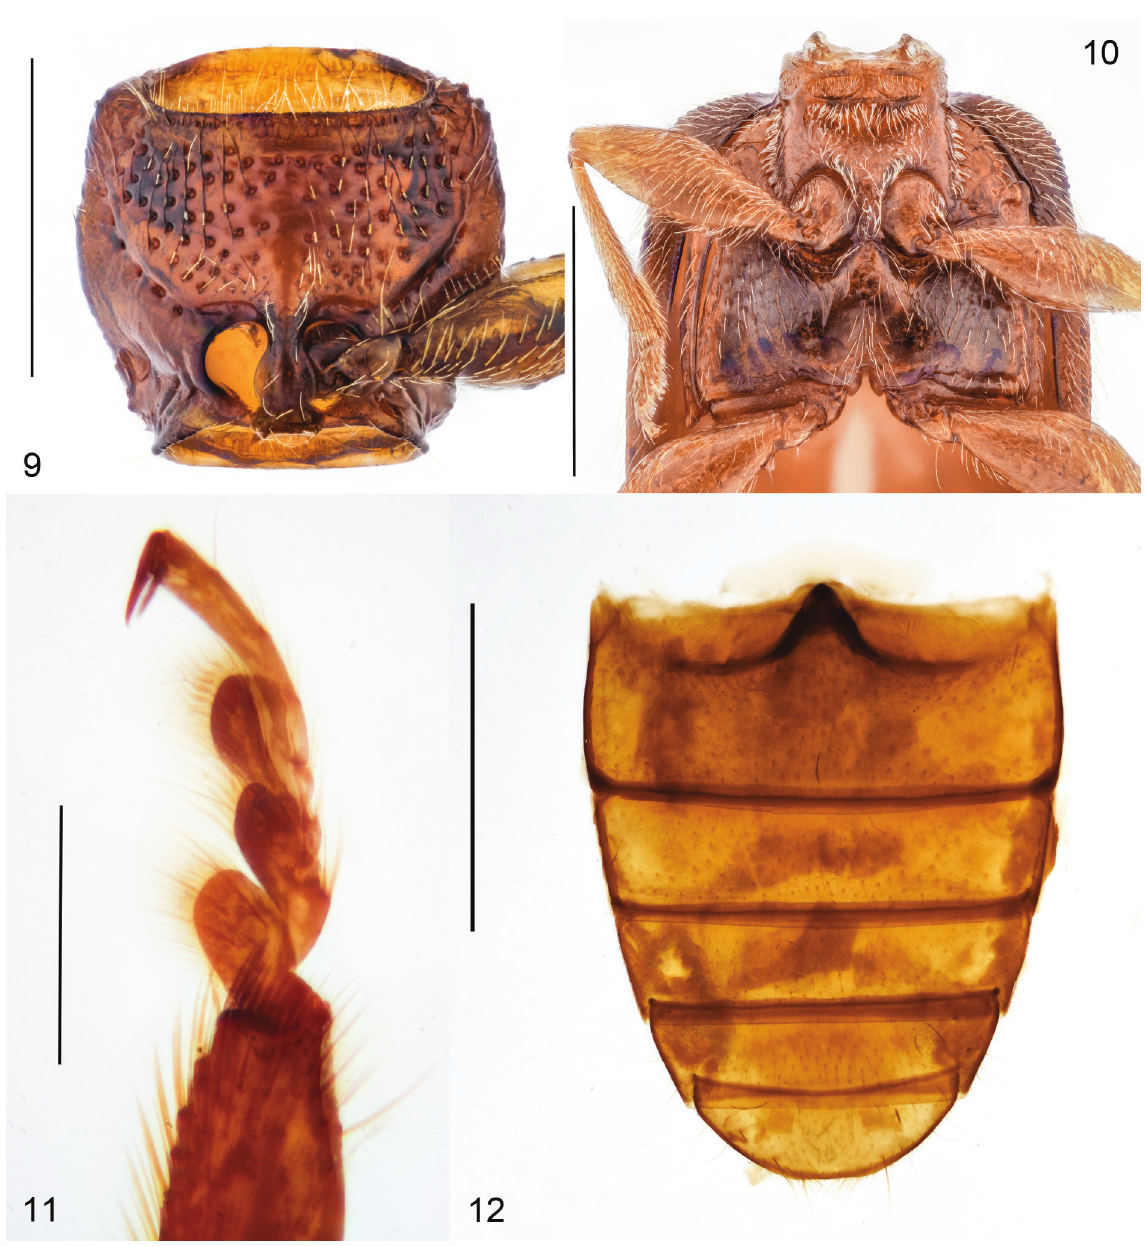
Figs 9–12. Bolianus giannae gen. et sp. nov., paratype. 9 . Pronotum, ventral view (right anterior leg removed). 10 . Meso- and metathorax, ventral view. 11 . right anterior tarsus. 12 . abdominal ventrites. Scale bars: 9–10, 12 = 1.0 mm, 11 =